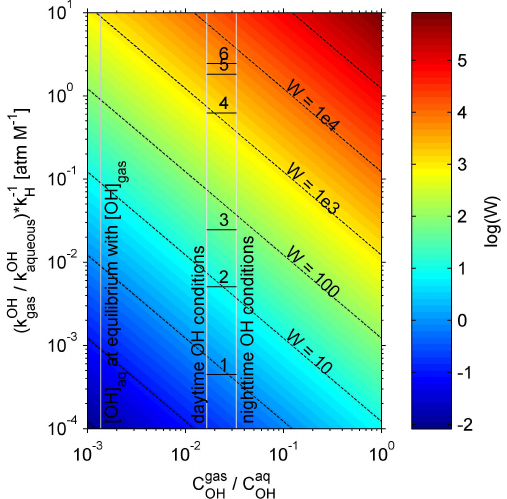
Henry’s law constant (atm M − 1 ) is represented on the